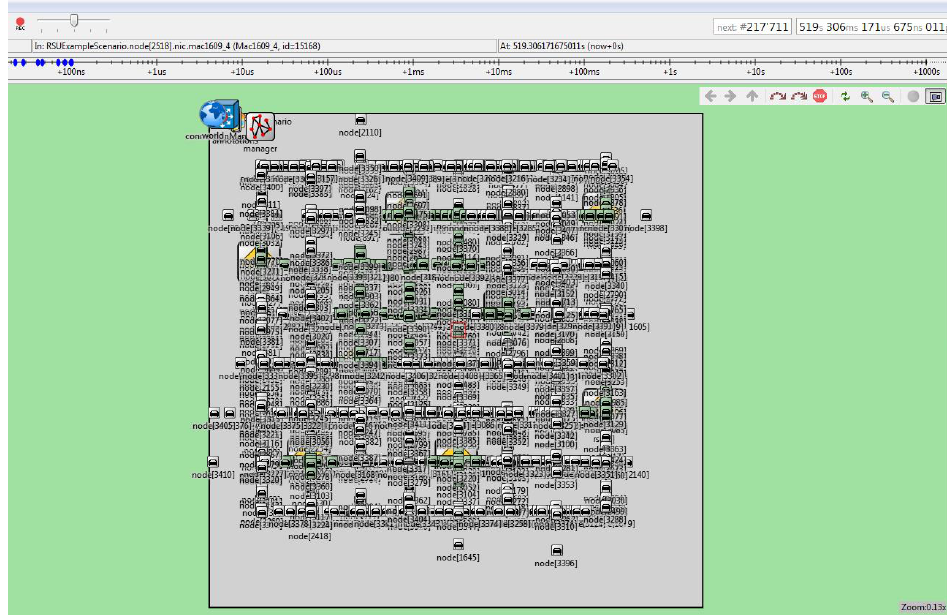
Figure 20. All RSUs have already sent the message once.